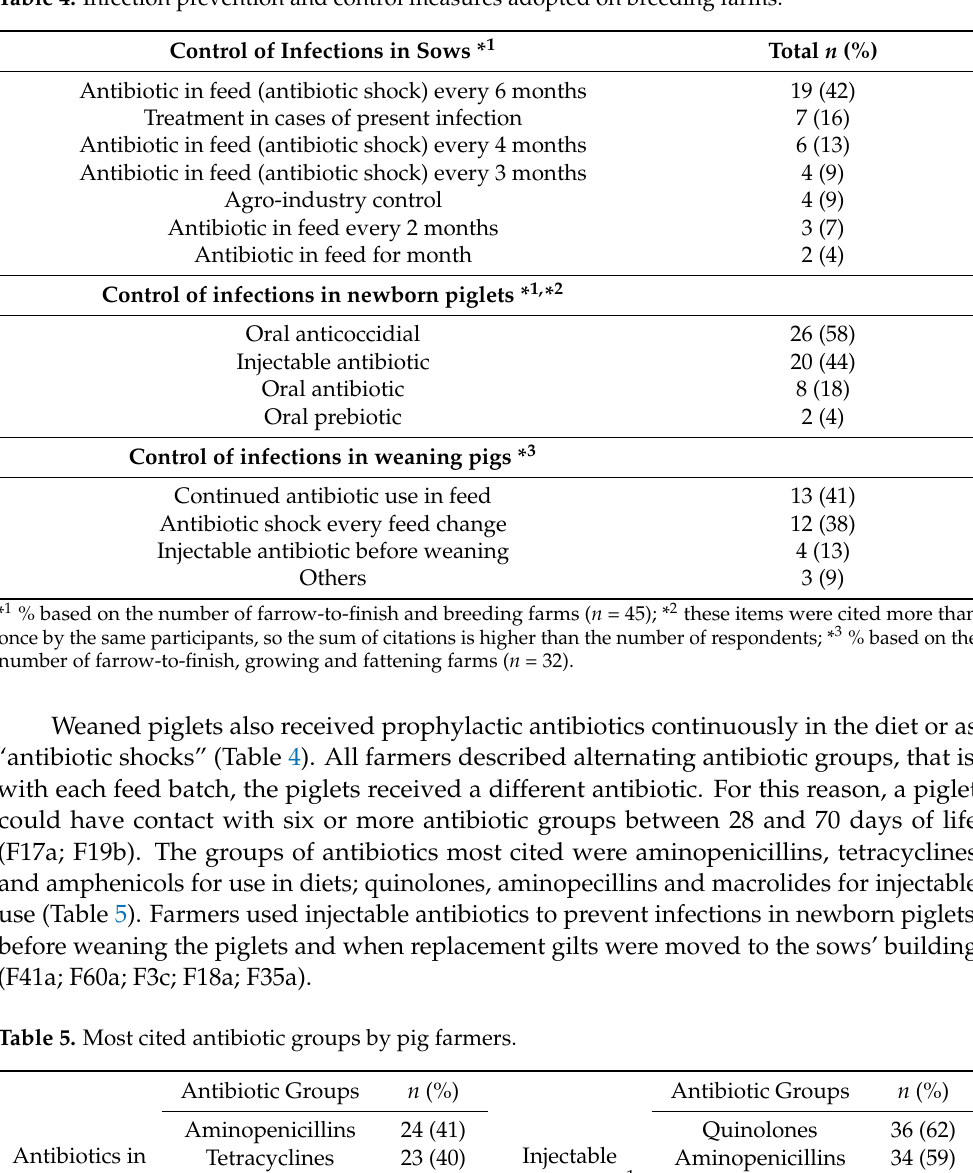
Table 4. Infection prevention and control measures adopted on breeding farms.